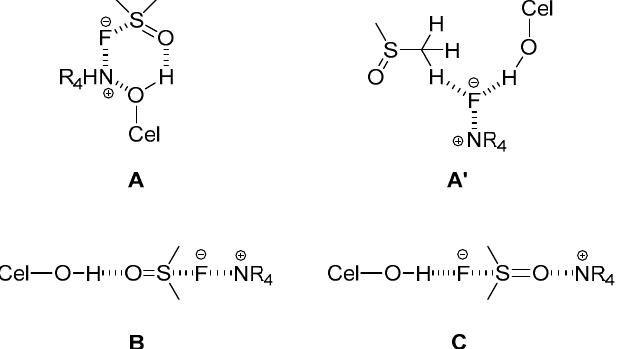
Figure 6. Schematic representations of the structures of interest, including, the starting geometries of the aggregates ( A – C ), and ( A ’) an optimized geometry of A [140,141]; redrawn from [90].